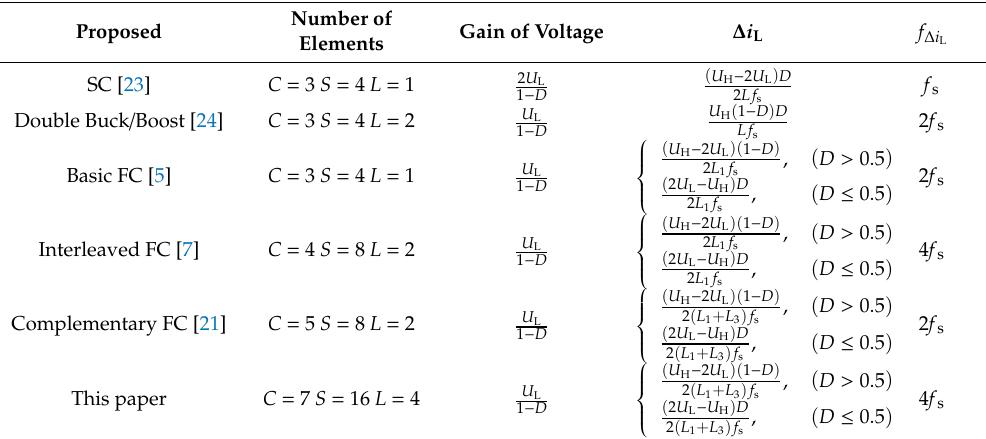
Table 4. Topological comparison.